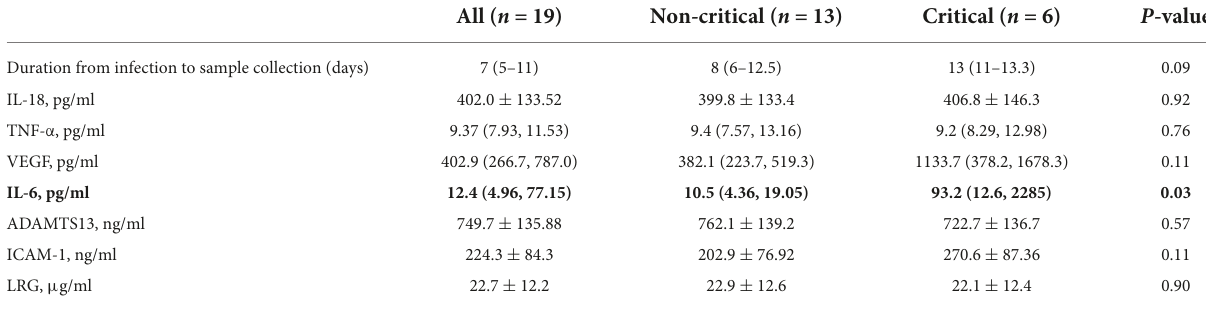
TABLE 2 Levels of serum biomarkers associated with inflammation and thrombosis in critical and non-critical COVID-19 patients. All ( n = 19) Duration from infection to sample collection